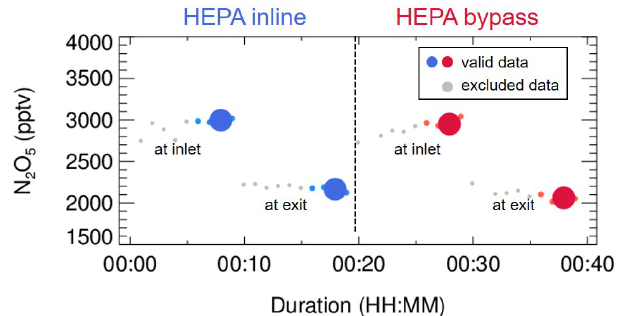
Figure 4. Variations of S a and N 2 O 5 concentrations (normalized to peak values) measured at the exit of flow tube when switching the sampling mode. The phases of species concentrations in the flow tube approaching stable after a mode switch are denoted as the tran- sition